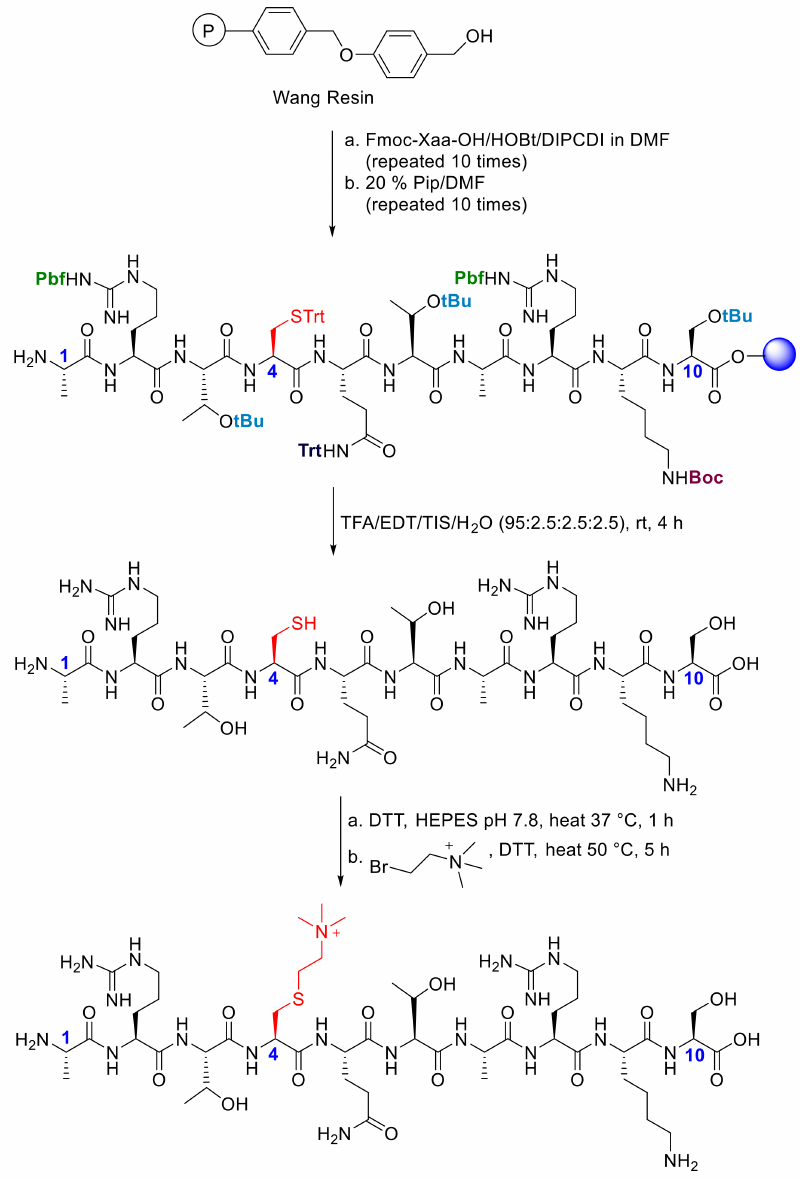
Figure 2. Solid-phase peptide synthesis of histone peptide H3K C